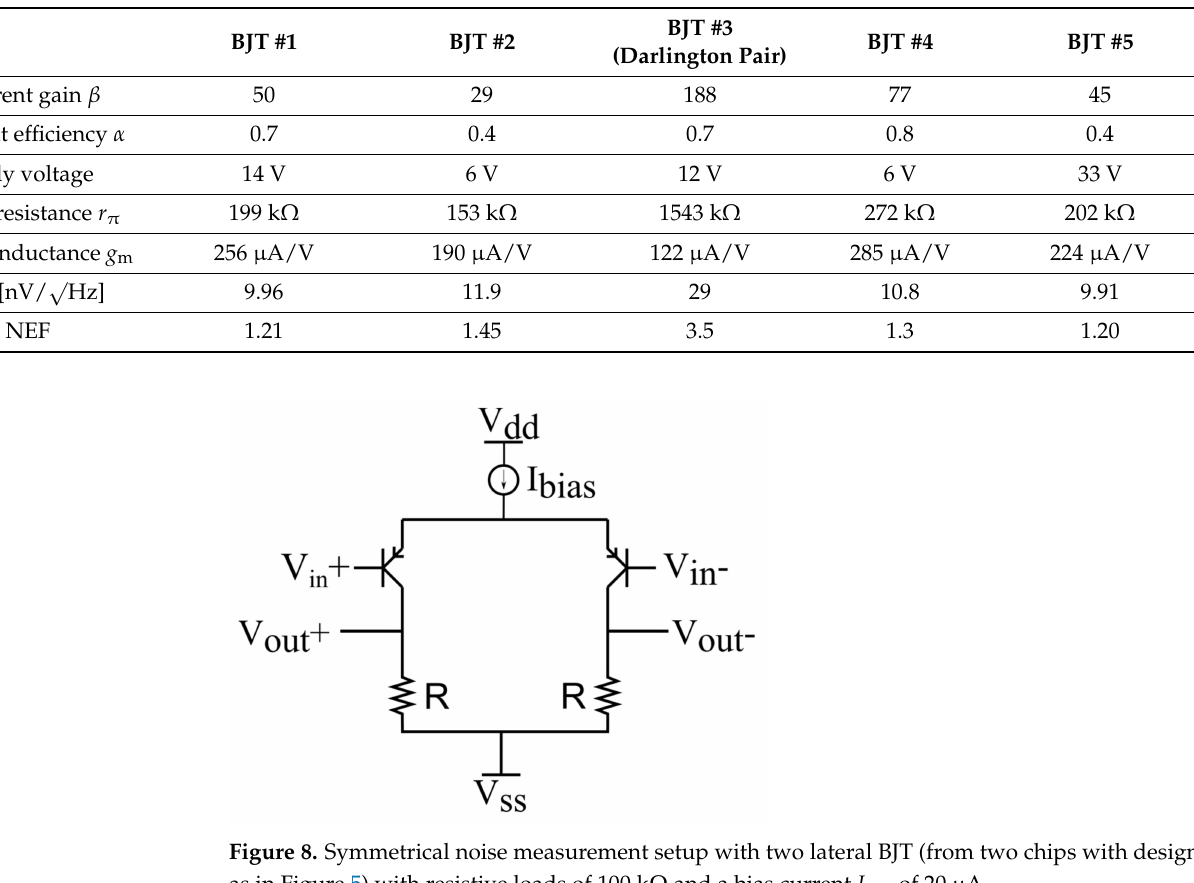
Table 2. Measured results of the lateral BJT Prototypes shown in Figure 7b with 10 µ A emitter bias current ( I bias = 20 µ A).